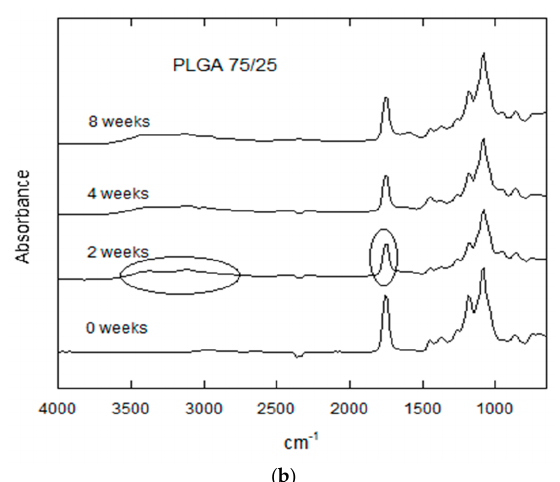
Figure 7. ( a ) FTIR spectra of nHA, PLGA (75/25) and PLGA (75/25)/nHA 10%; ( b ) FTIR spectra of PLGA (75/25) and PLGA (75/25)/nHA 30% after various degradation times.